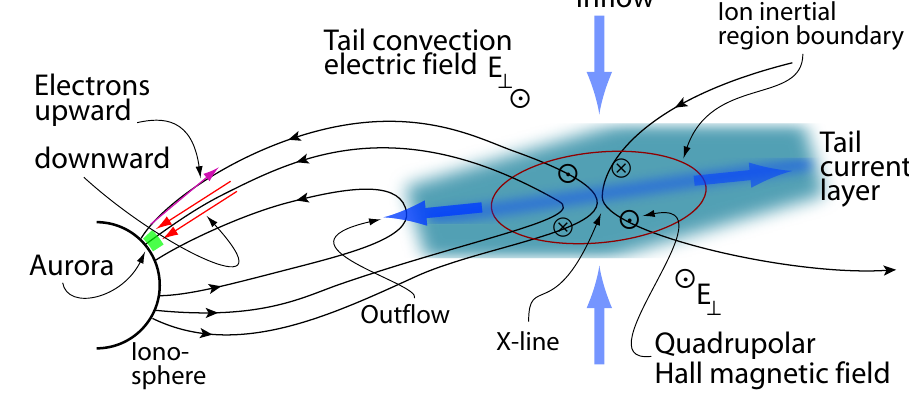
Fig. 2. Schematic representation of the magnetic connection between the reconnection site in the geomagnetic tail current sheet, the ion- inertial region, convection electric field, Hall magnetic field, and the auroral region with the upward and downward electron fluxes (drawing not to